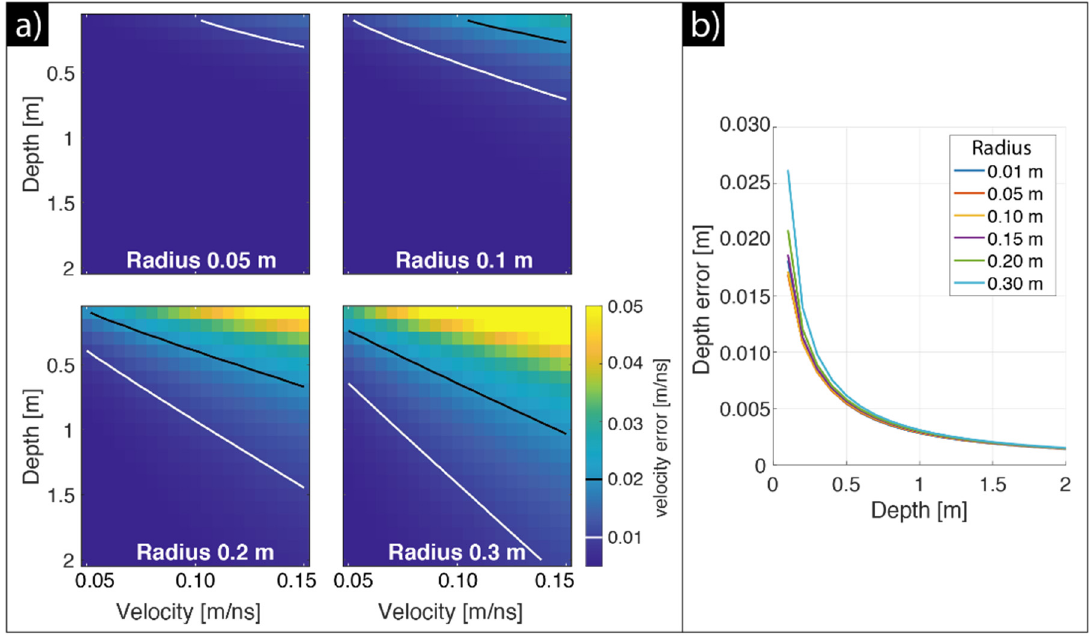
Figure 9. Velocity error ( a ) and depth error ( b ) for different depths, radii, and velocities if neither the right offset nor radius of the object is taken into account. The depth error is independent of velocity.